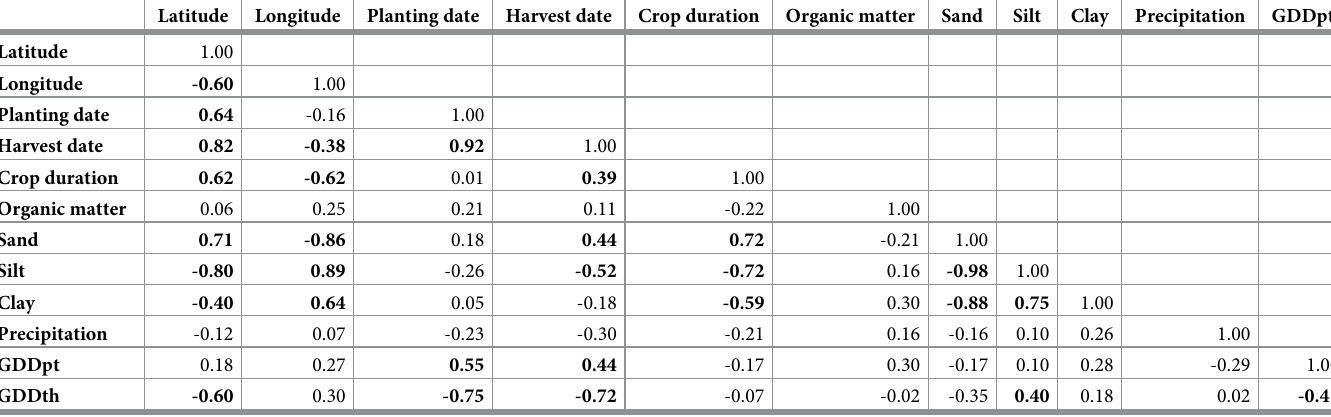
Table 3. Pearson’s partial correlation coefficients between environmental and crop management variables of thirty fields in which optimum plant density for pro- cessing sweet corn was quantified in field trials in Illinois, Minnesota, and Wisconsin from 2013 to 2017. Coefficients in bold are significant at α = 0.05. GDDpt and GDDth represent growing degree days observed during planting-tassel and tassel-harvest,